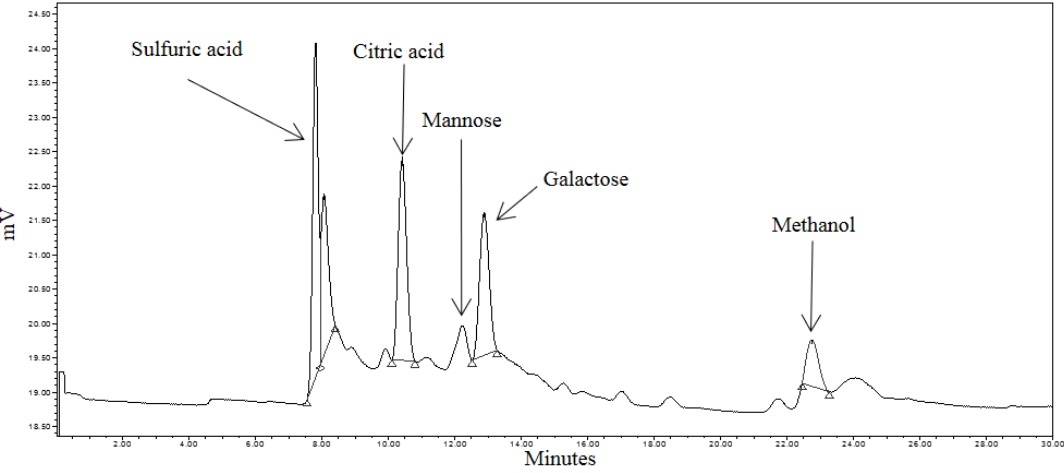
Figure 5. HPLC (High Performance Liquid Chromatography) chromatogram of spent coffee waste (control) sample.